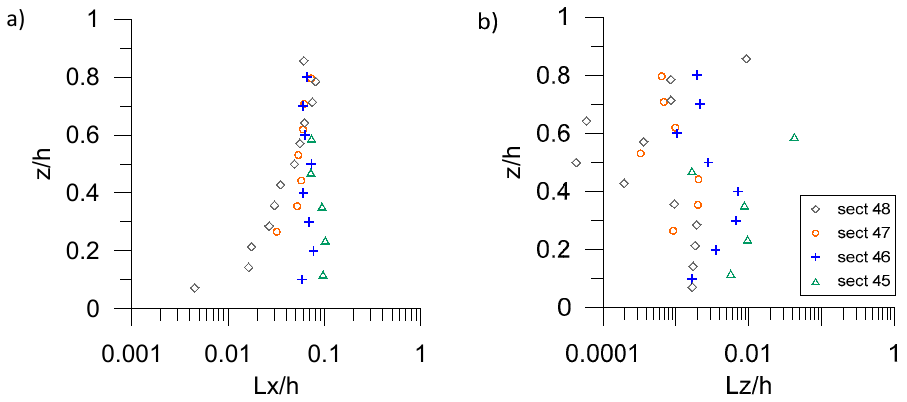
Figure 7. Test_S: time-averaged horizontal (a) and vertical (b) integral length scales.